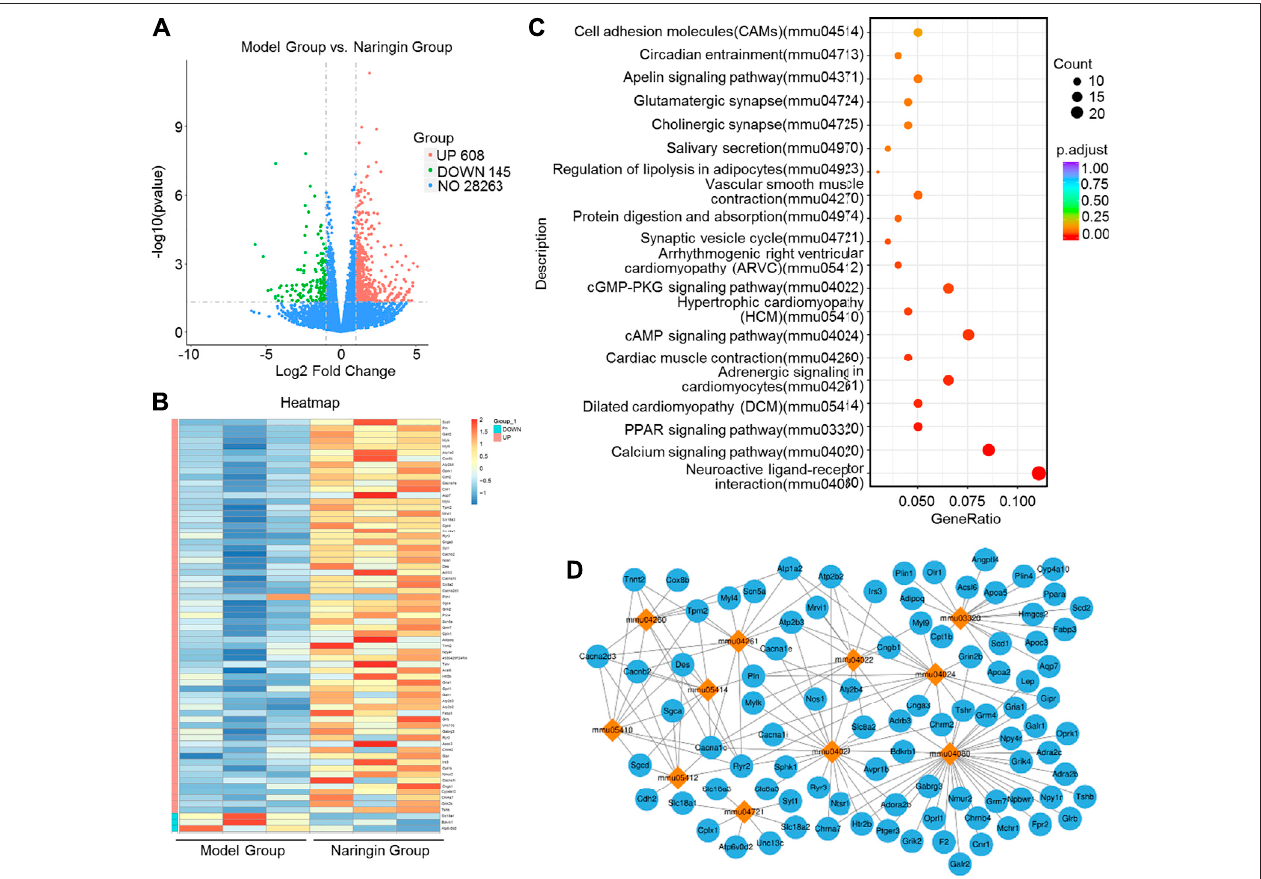
FIGURE4| High-throughputtranscriptomesequencingandKEGGpathwayenrichmentanalysis.Naringin(40 mg/kg)wasadministeredtomicebygavageoncea day for seven consecutive days and total RNA was extracted from colonic epithelial cells. (A) Volcano plot ofdifferentially expressed mRNAs in model group vs.